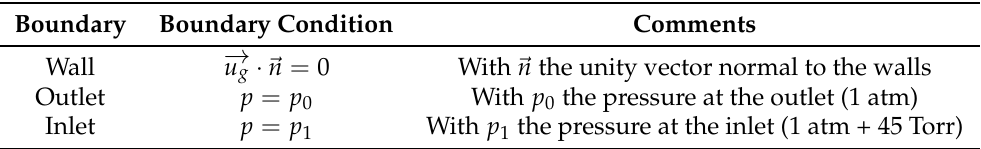
Table 1. Boundary conditions of the k − ε